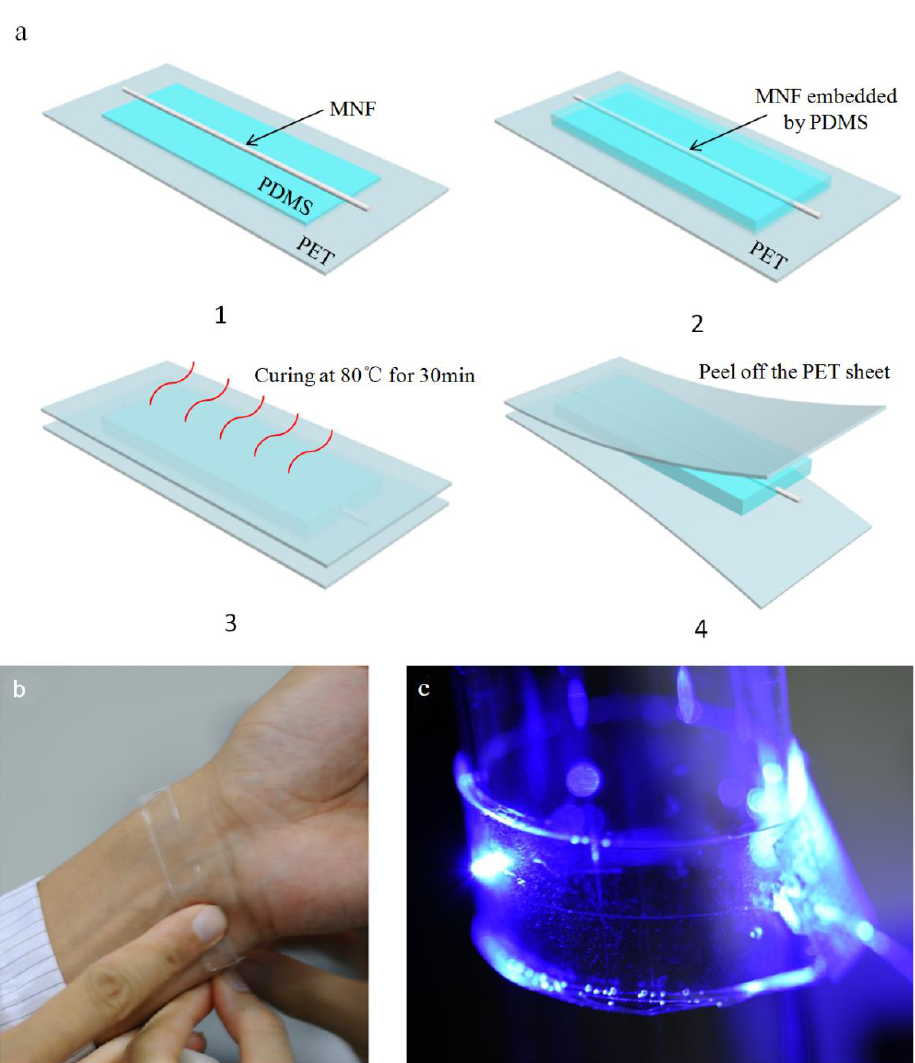
Figure 1. ( a ) Schematic illustration of the fabrication process of the sandwich-like SOFS. ( b ) Photograph of an SOFS attached to the wrist. ( c ) Photograph of an MNF-embedded PDMS patch pasted onto a glass tube.